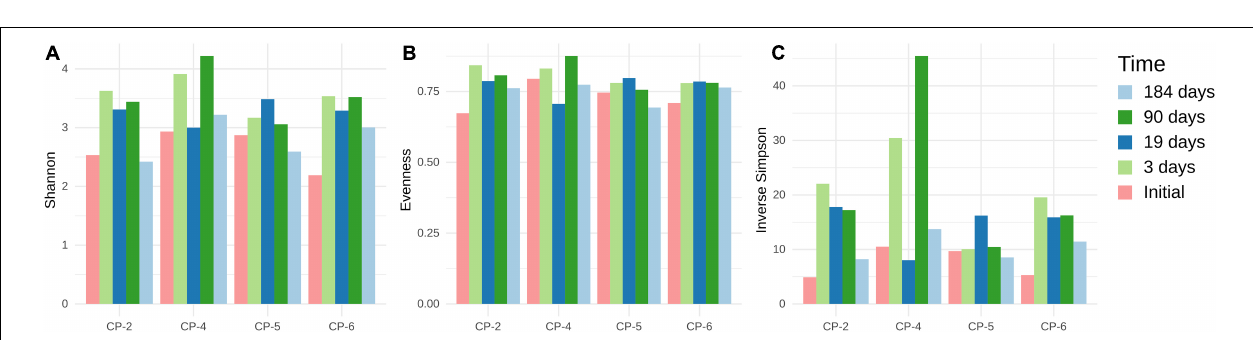
FIGURE 8 | Alpha -diversity indices of microbial communities in groundwater samples from CP-2, CP-4, CP-5 and CP-6 monitoring wells, before the treatment (Initial) and at different times after the addition of nZVI, calculated from ARISA data. (A) Shannon-Wiener index; (B) Pielou’s Evenness; (C) Inverse Simpson index